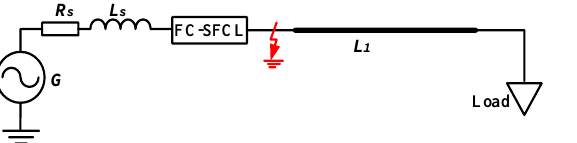
Figure 2. The 10 kV single-phase system.